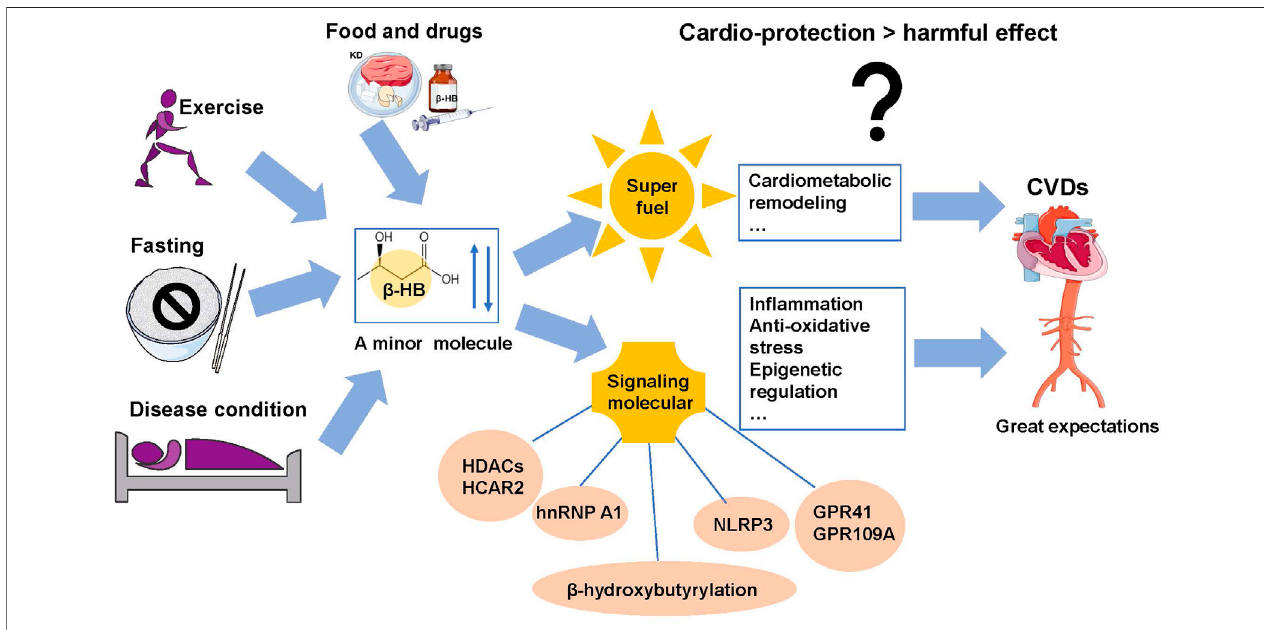
FIGURE2 | Summaryof regulation of β -HB levels and its multi-effects on CVDs. Fasting, exercise, ketogenic diet, drugs, and some disease conditions change the endogenous β -HB levels. Beyond their contribution to energy generation, β -HB may exert signaling effects on in fl ammation, oxidative stress, cell death, and cardiac remodeling that may induce either the prospective cardiovascular protection or harmful effect on